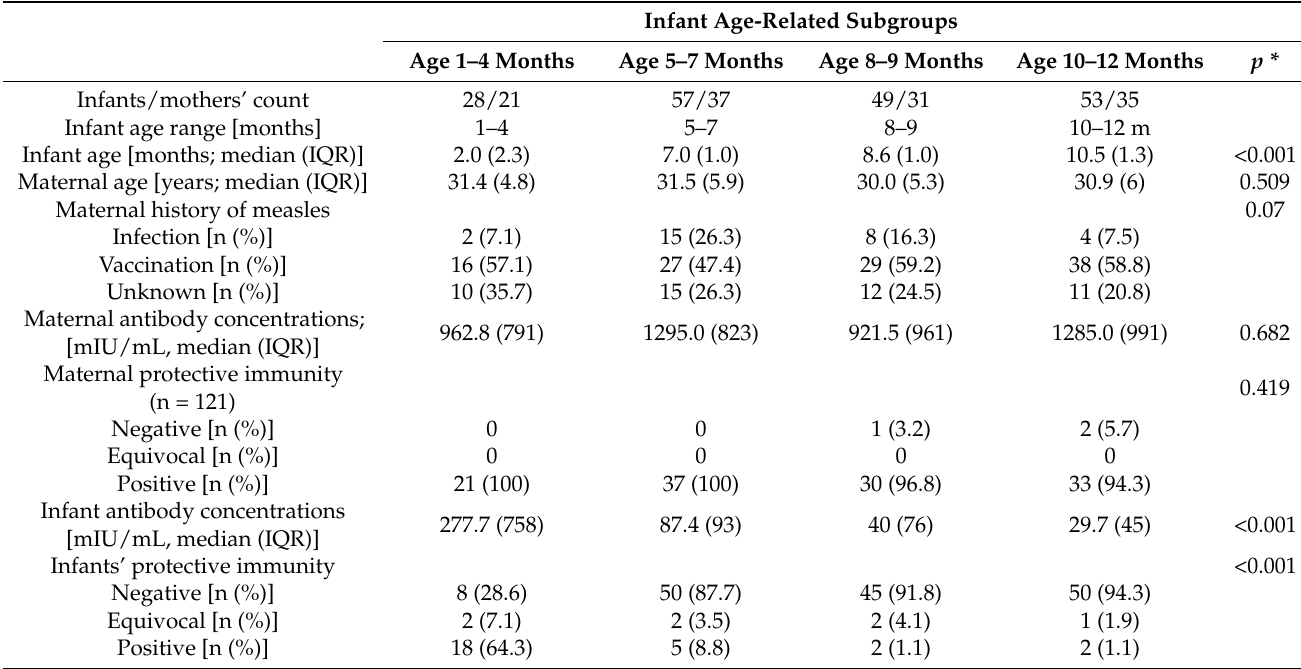
Table 3. Maternal and infant data in the four infant age-related subgroups.